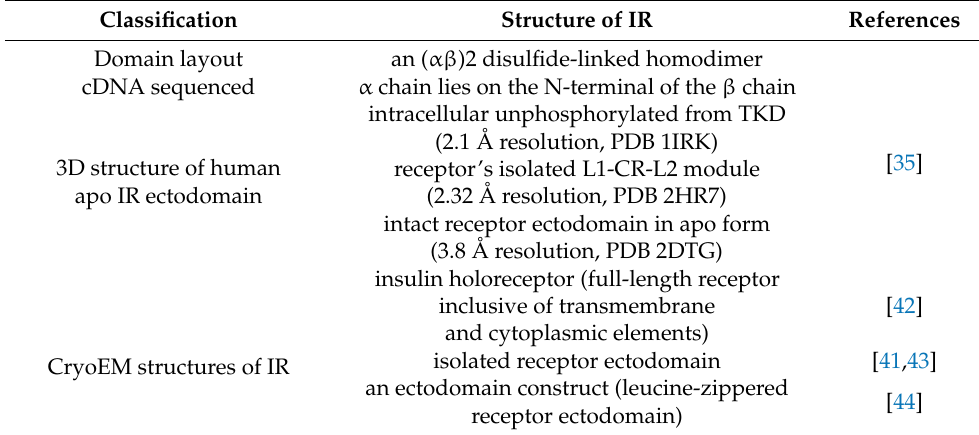
Figure 1. ( a ) The architectural domain of the IR ( αβ ) 2 homodimer. Black lines indicate the intersub- unit disulfide bonds; ( b ) Inactive and active states of the IR; L1, L2, leucine-rich repeat domains 1, 2; CR, cysteine-rich domain; FnIII-1, 2, 3, fibronectin type-III domains 1, 2, 3; α CT, α C-terminal regions; TM, transmembrane; JM, juxtamembrane; KD, kinase domain; CT, C-terminal tail; ECD, ectodomain; TMD, transmembrane domain; TKD, tyrosine kinase domain. Table 1. Summary of the available structures of